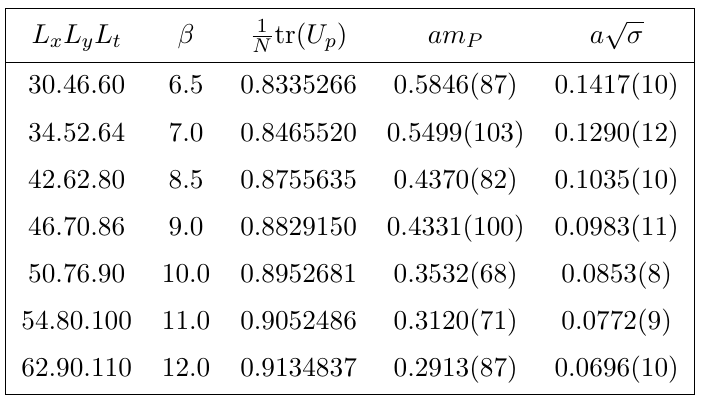
Table 11 . SO(3) average plaquette values, masses of (cid:13)ux loops winding around the x -torus, and resulting string tensions on the lattices shown.